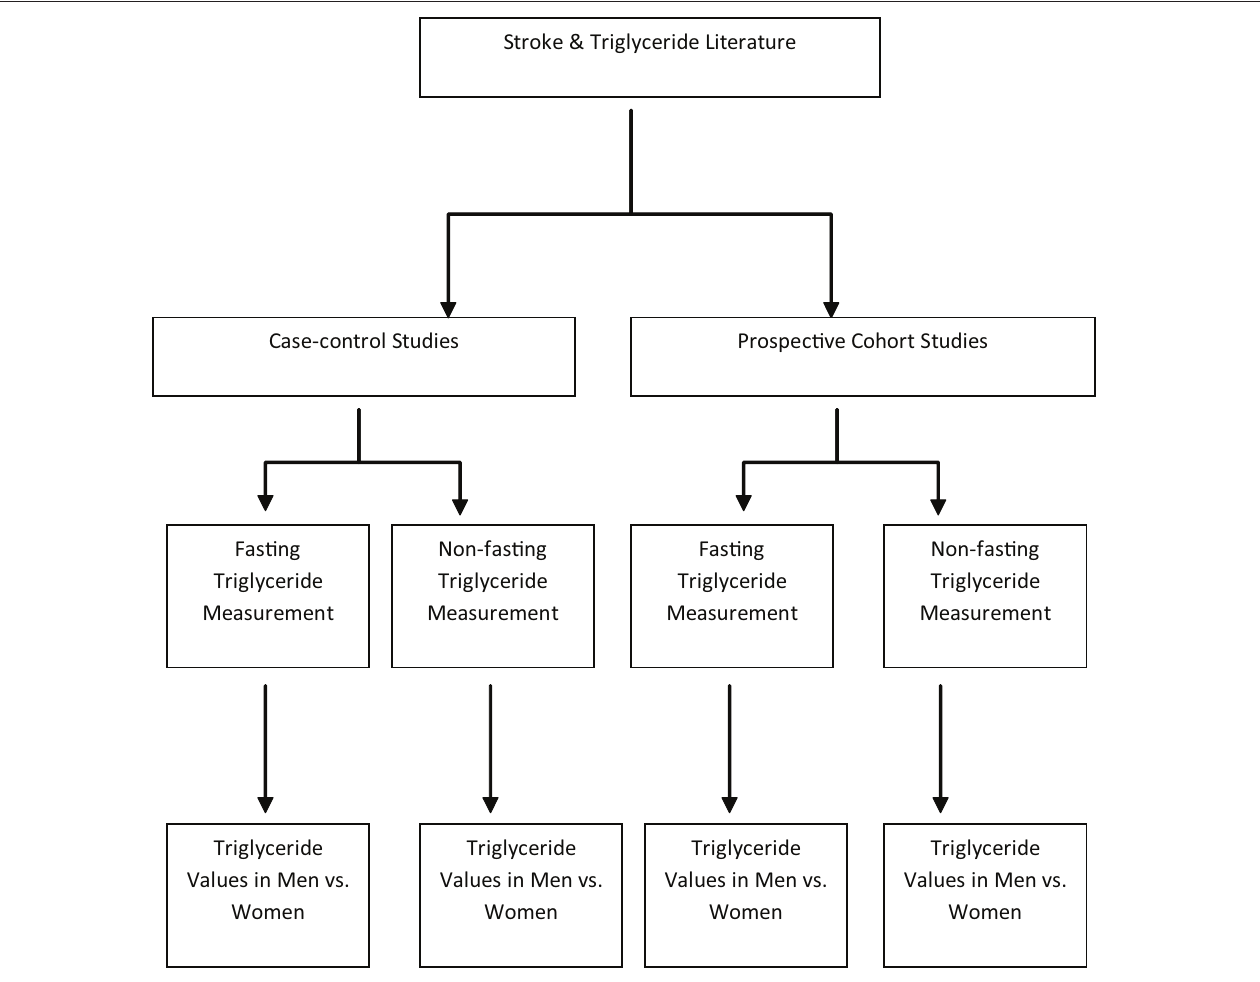
FiguRe 1 | Flow diagram illustrating the subdivisions of the stroke literature pertaining to triglyceride